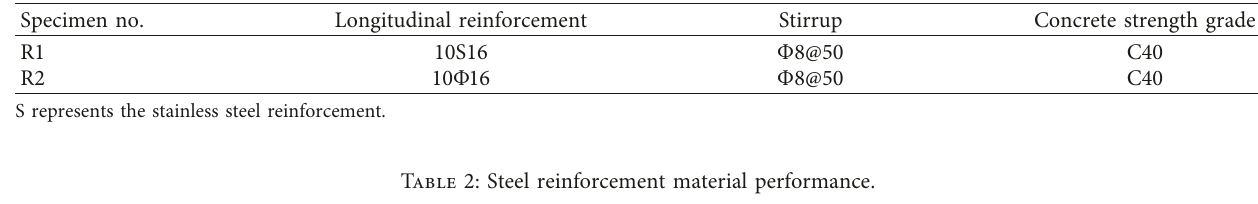
Table 1: Specimen design parameters.